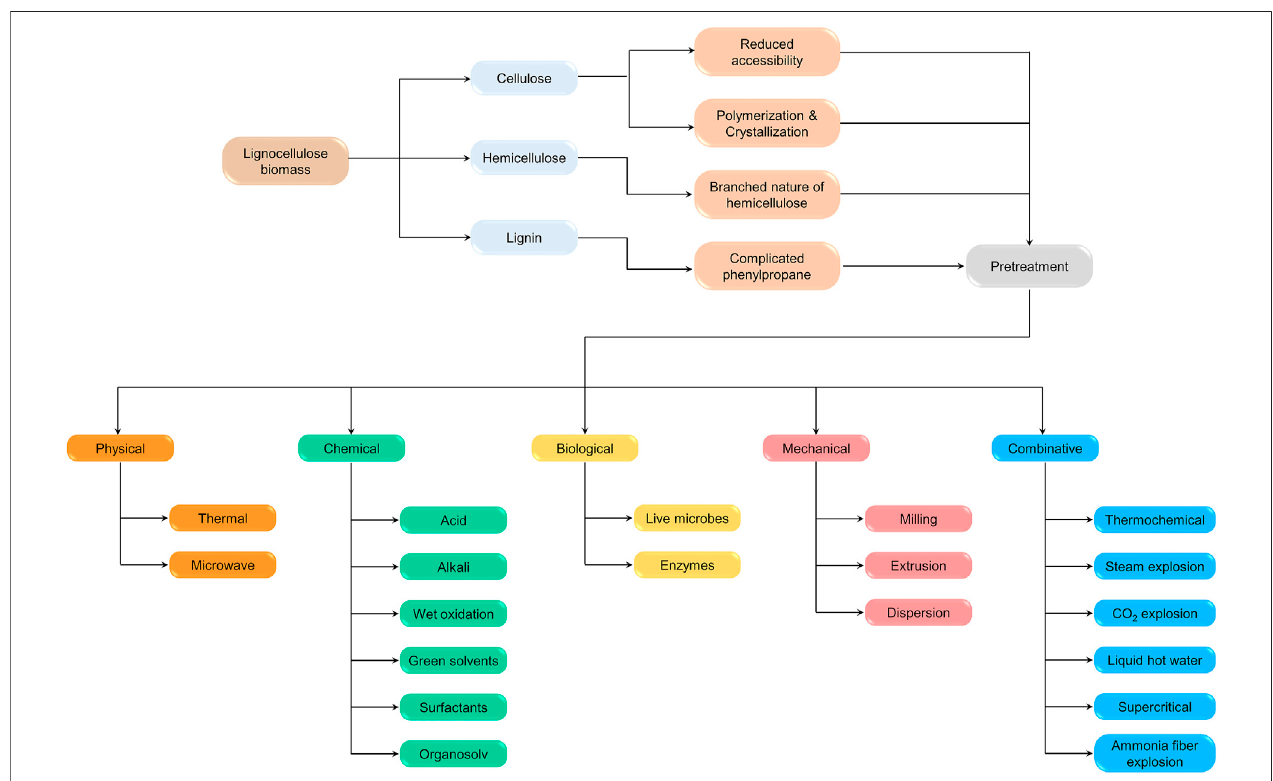
FIGURE 1 | Overall concept diagram of the present